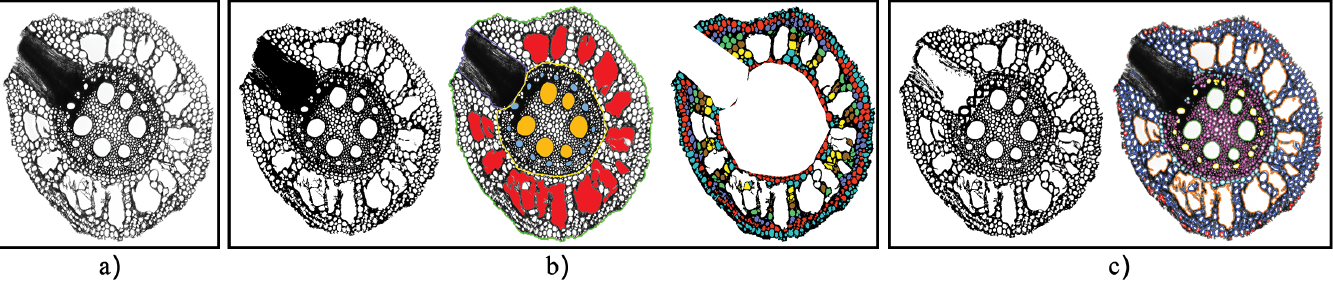
Fig 10. RootScan and RootAnalyzer applied to a sample maize image. (a) The original image. (b) Results from RootScan. (c) Results of RootAnalyzer.